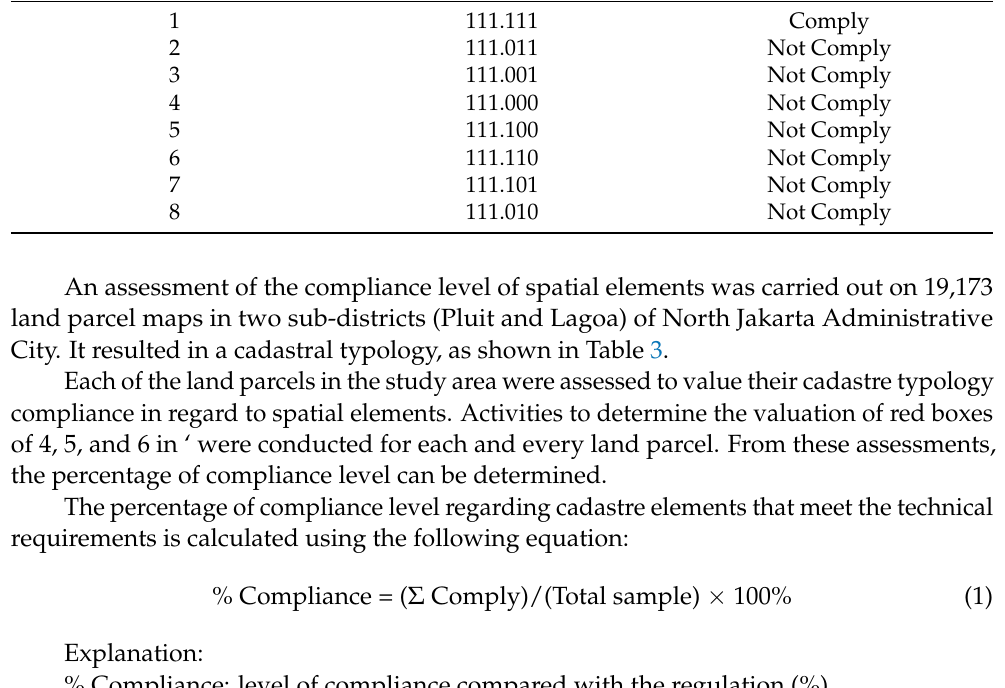
Table 3. Cadastre typology in 2 sub-districts in North Jakarta Administrative City.